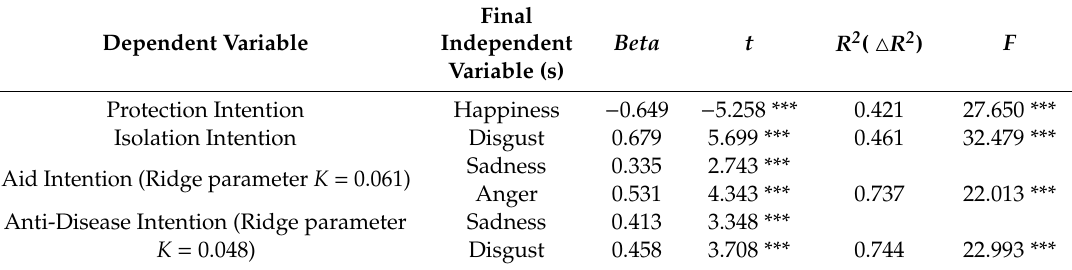
Table 9. Details of multiple regression—emotions and behavioral intentions.